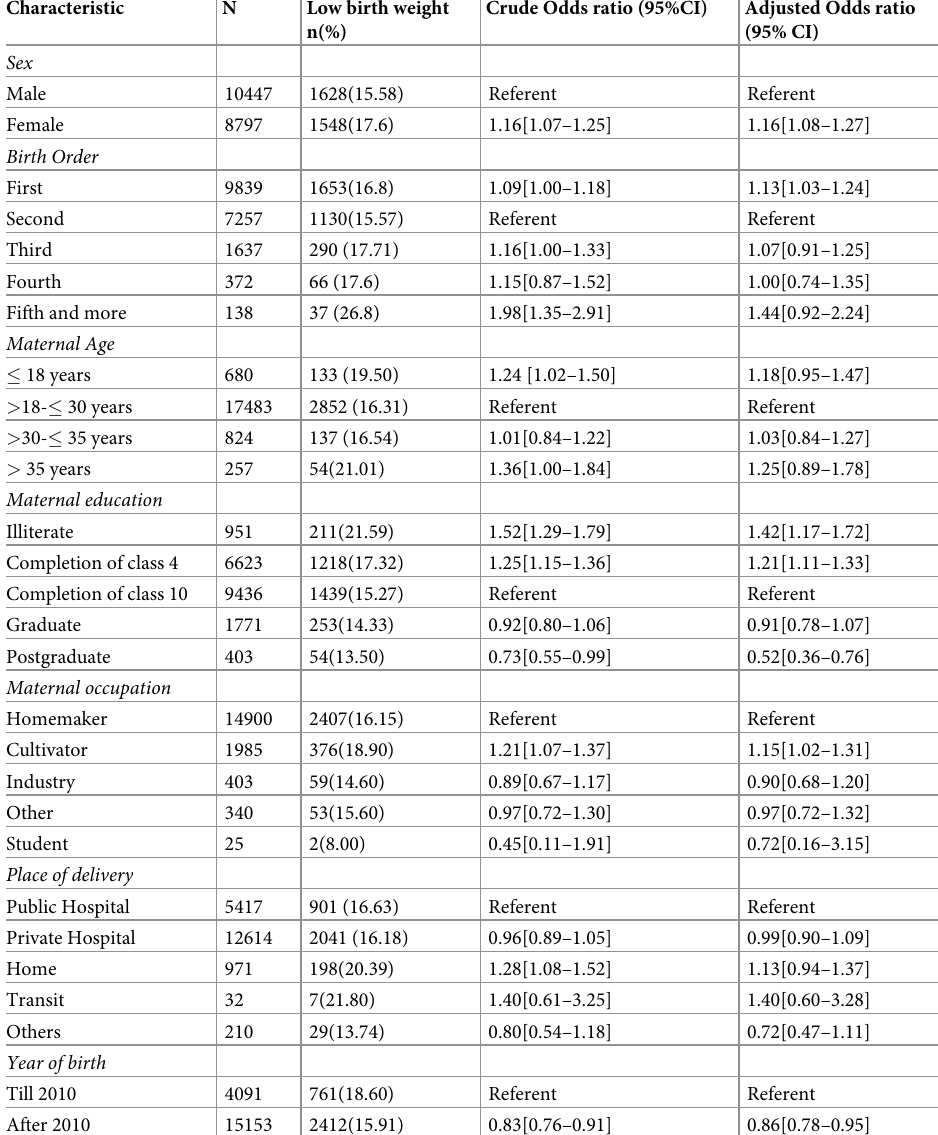
Table 3. Factors associated with low birth weight based on logistic